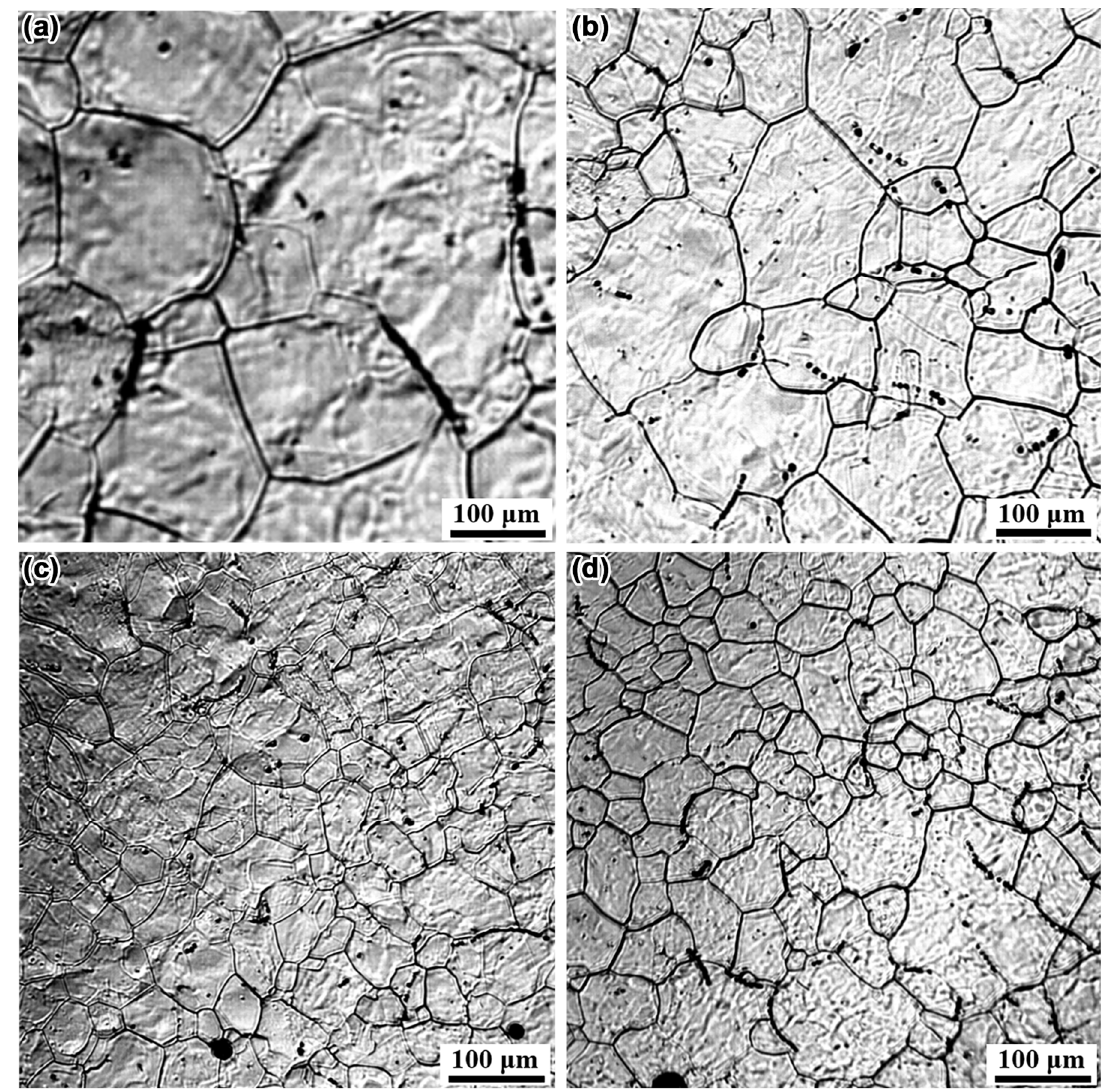
Figure 9. In situ observation of austenite grain size in N1 ( a ), N2 ( b ), N3 ( c ), and N4 steel ( d ).